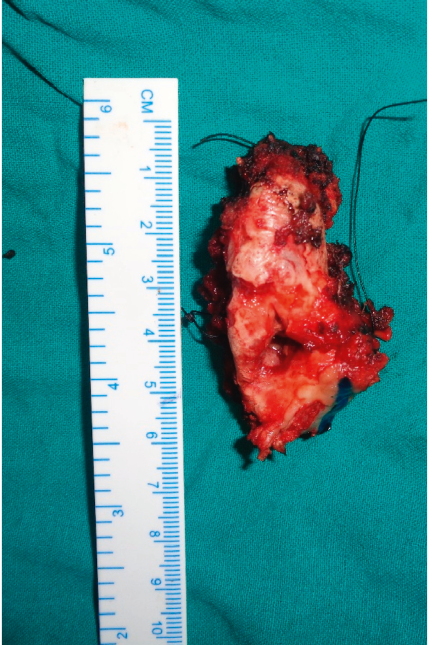
Figure 3: Surgical